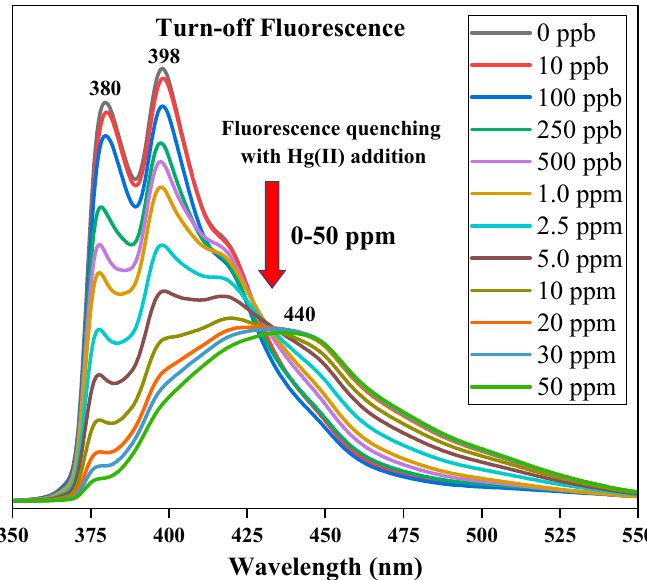
Figure 6. PL emission spectra of Pyr-NH@SiO 2 NPs (20 ppm) before and after exposure to Hg 2+ ions in the concentration ranged from 0 – 50 ppm ( λ ex = 340 nm).